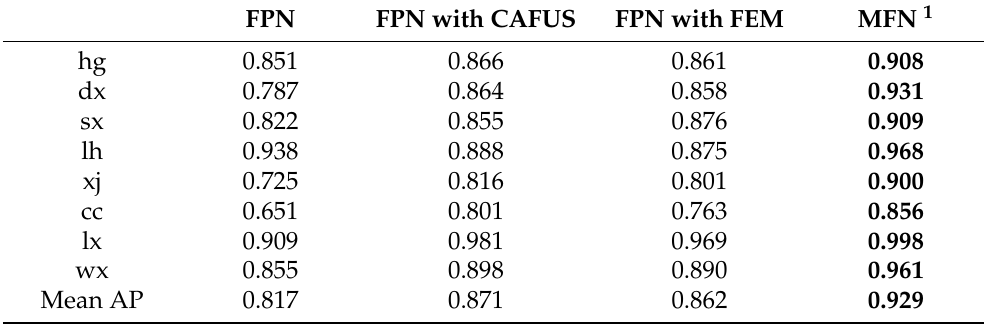
Table 2. APs and mAPs of different methods in the ablation experiment.